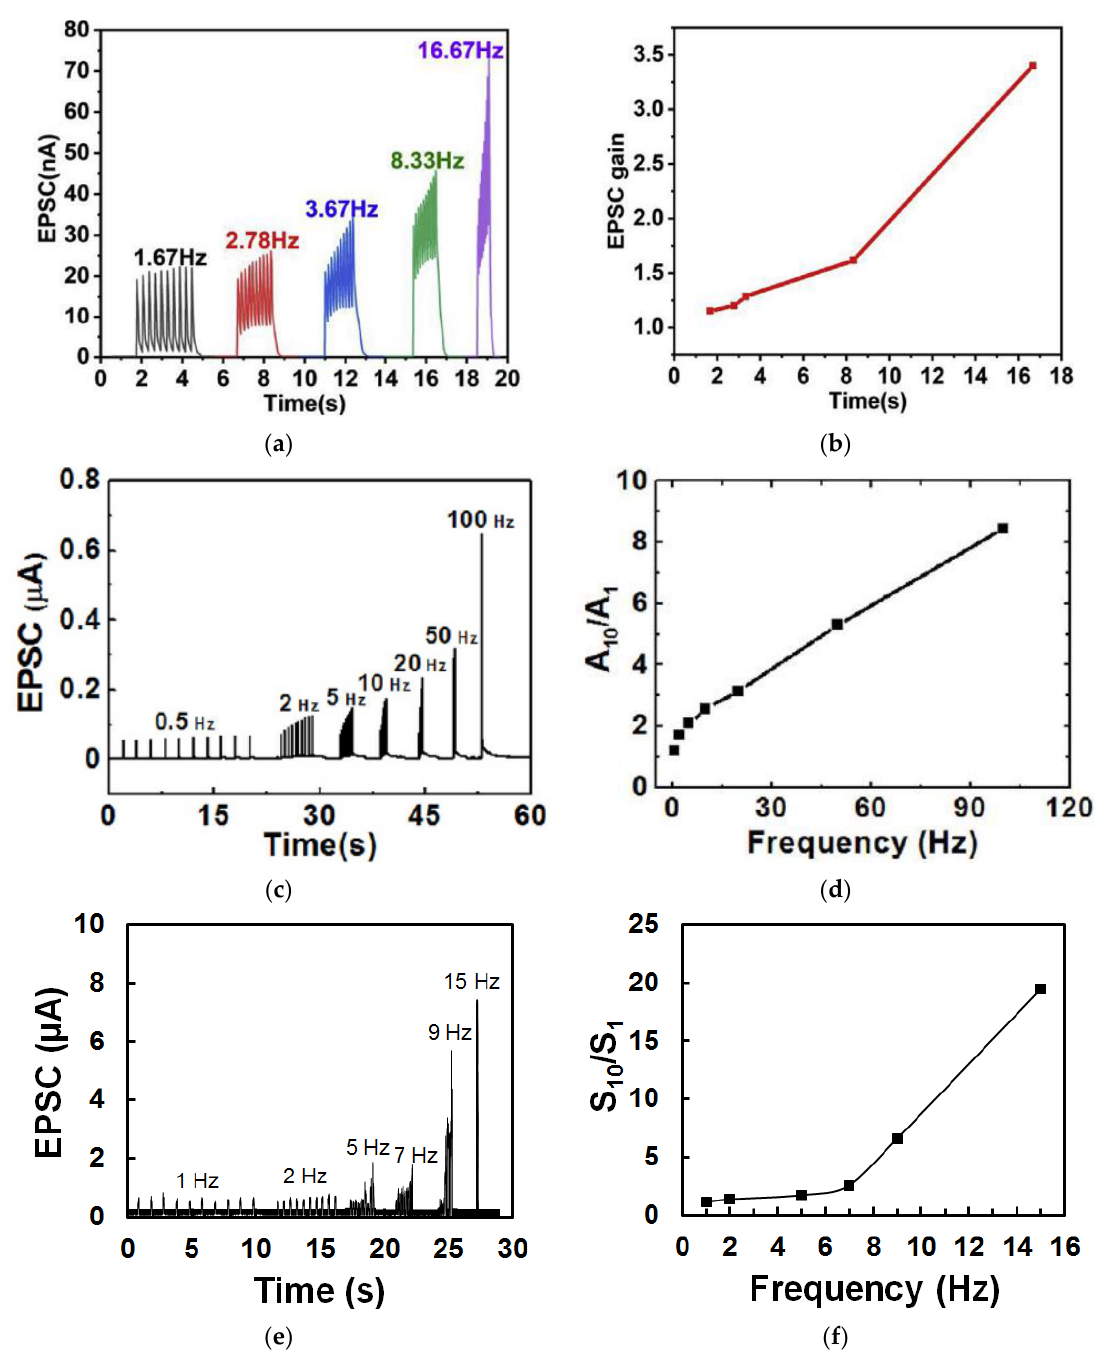
Figure 11. Dynamic filtering characteristics demonstrated in ( a , b ) gelatin [15] and ( c , d ) chicken albumen [43] gated synaptic transistors, and ( e , f ) honey-memristor [19].